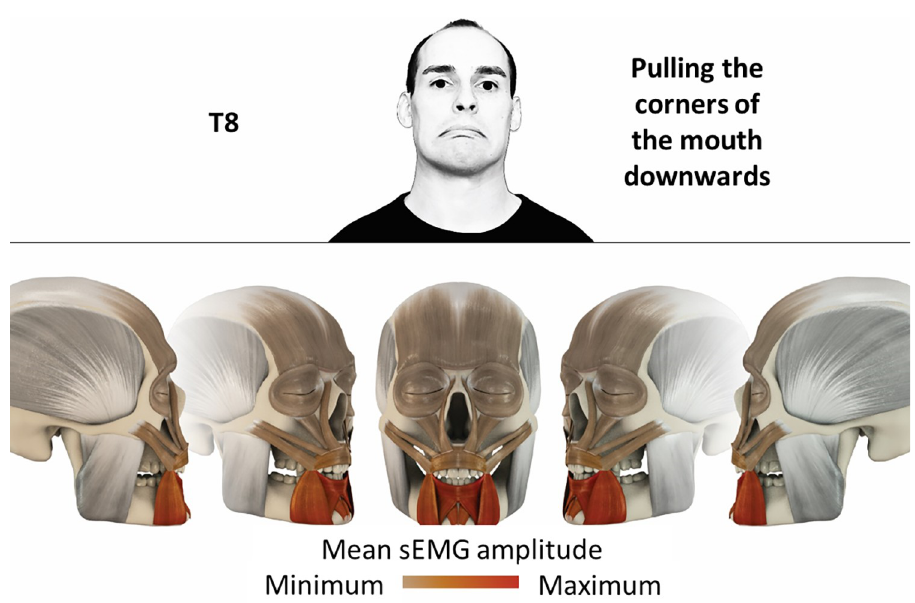
Fig 9. Color-coded facial muscle activation pattern of task T8. Pulling corners of the mouth downwards. Animation by Jonas Laustro¨er.